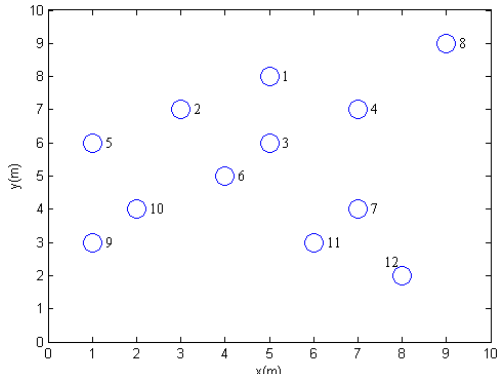
Figure 2. Network topology of the given